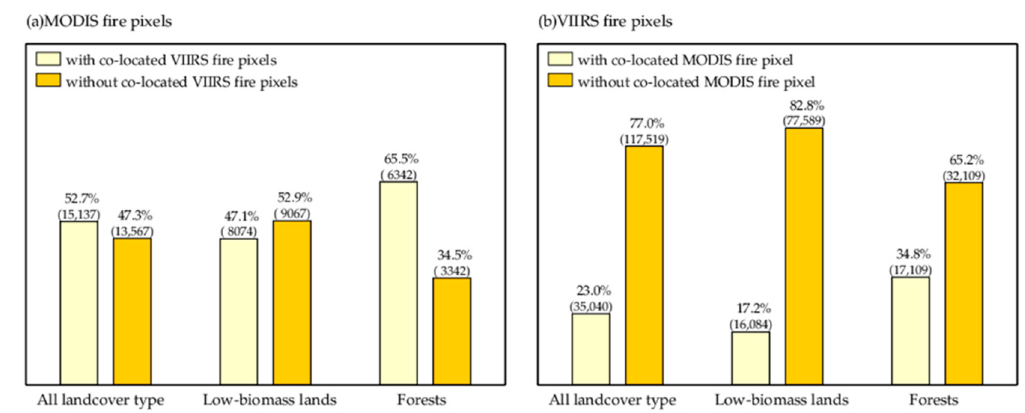
Figure 4. Proportions of ( a ) MODIS fire pixels with and without co-located VIIRS fire detections; ( b ) VIIRS fire pixels with and without co-located MODIS fire detections for the three broad cover categories: low-biomass lands, forests, and all land cover types (including low-biomass lands, forests, and all other cover types such as shrublands). The number of fire pixels is shown in parentheses. The number of fire pixels in 2015 is distributed in Figure 5, with fire pixels detected and undetected by the Landsat 30-m burned area shown in red and blue colors, respectively, to further explore the potential commission errors of the two fire products. As Figure 5 shows, a large part of fire detections that were undetected by Landsat burned area have a low FRP observation (e.g., < 10 MW for MODIS, and 3 MW for VIIRS). While for fire detections with relatively high FRP observation (e.g., > 120 MW for MODIS in Figure 5c, and > 40 MW for VIIRS in Figure 5f), these were generally detected by the Landsat burned area. Di ff erence between low-biomass lands and forests were observed in at least two ways. First, fires in forests have a generally higher FRP than fires in low-biomass lands as the number of fire pixels in forests distributes in a higher value region of FRP compared with that in low-biomass lands. Second, the proportion of fire pixels undetected by Landsat are likely much higher in low-biomass lands than in forests (Figure 5b,e vs. Figure 5c,f).